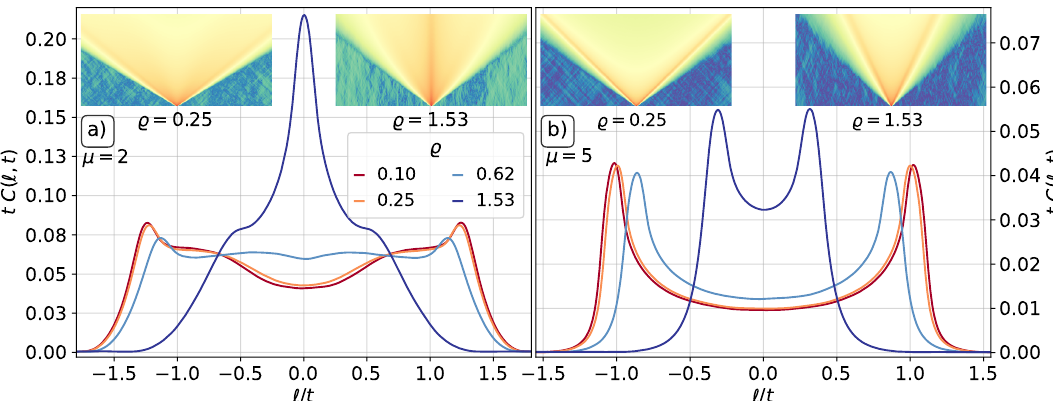
Figure 6: Ballistic stationary scaling profiles of dynamical structure factors S ( (cid:96) , t ) (shown in insets) computed at µ = 2,5. Simulation parameters: τ = 1, L = 2 12 , averaged over 10 5 initial